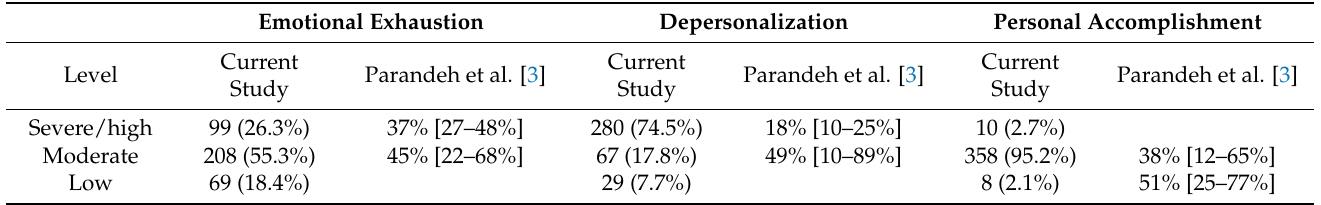
Table 1. Nurses falling within severe, moderate, and low levels of burnout for the current study compared with a meta-analysis of burnout in healthcare workers during the pandemic [3].